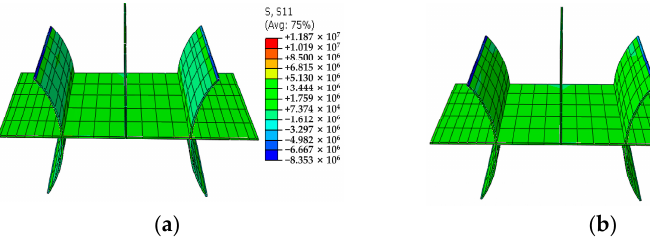
Figure 14. The horizontal stress of the temporary support in different conditions (unit: Pa): ( a ) Condition 1; ( b ) Condition 2; and ( c ) Condition 3.